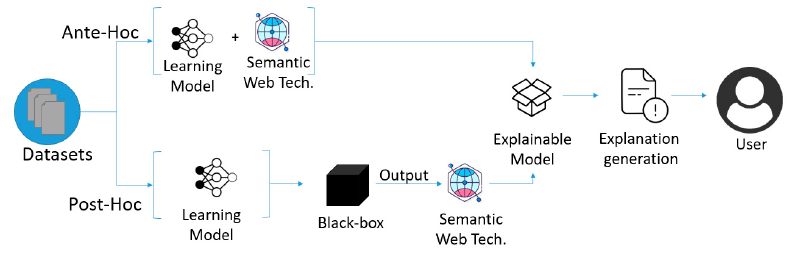
Figure 1. ML explanation approaches.